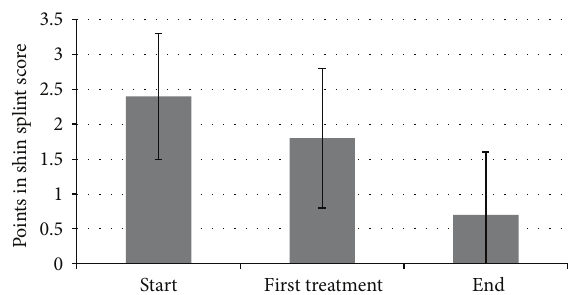
Figure 3: Velocity in shin splint score.